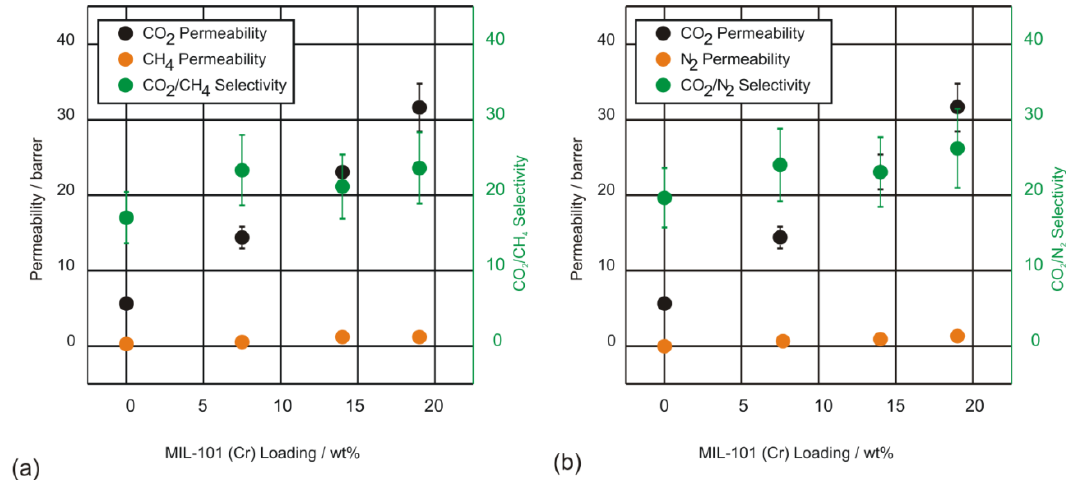
; ( b ) CH and N permeabilities; ( c ) ideal CO 2 4 2